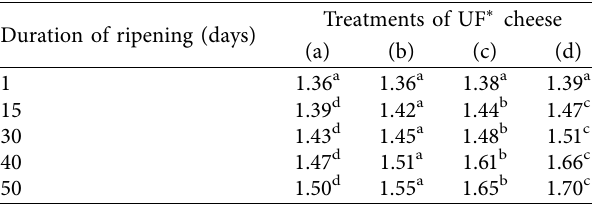
Table 1: Acid degree value (meq KOH 100g − 1 fat) of UF white ∗ cheese a,b made with NaCl or mixtures of NaCl and KCl during 50 days of storage